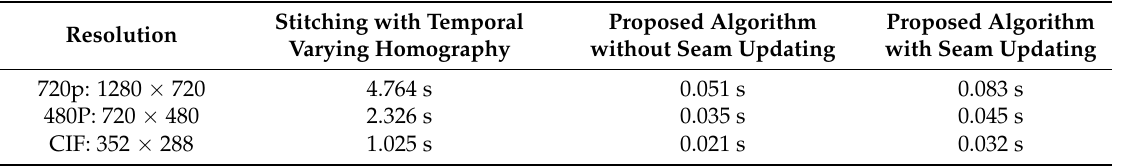
Table 1. Comparisons of the speed among different video stitching methods on input-videos with different